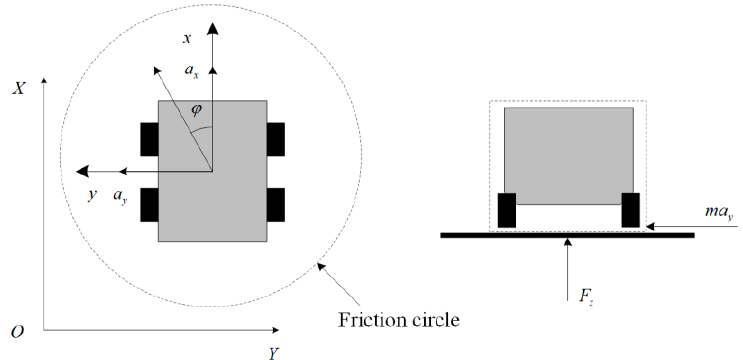
Figure 7. Point mass vehicle model for trajectory re-planning layer.